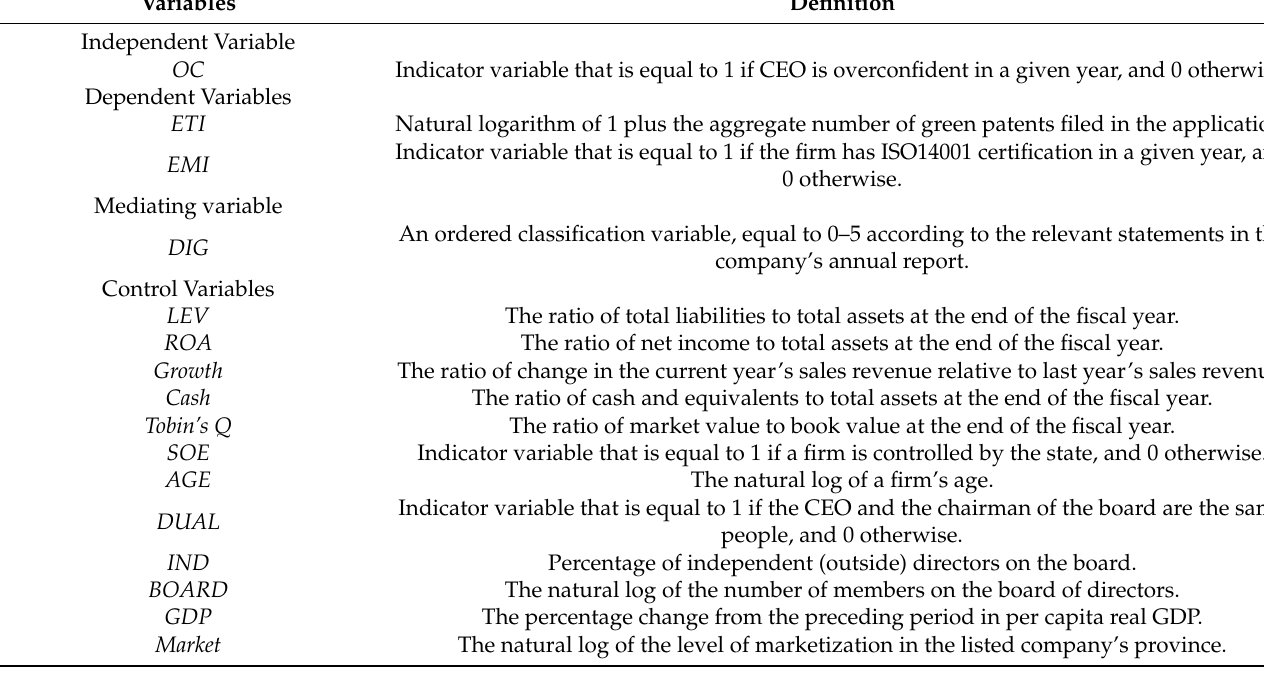
Table 2. Variable